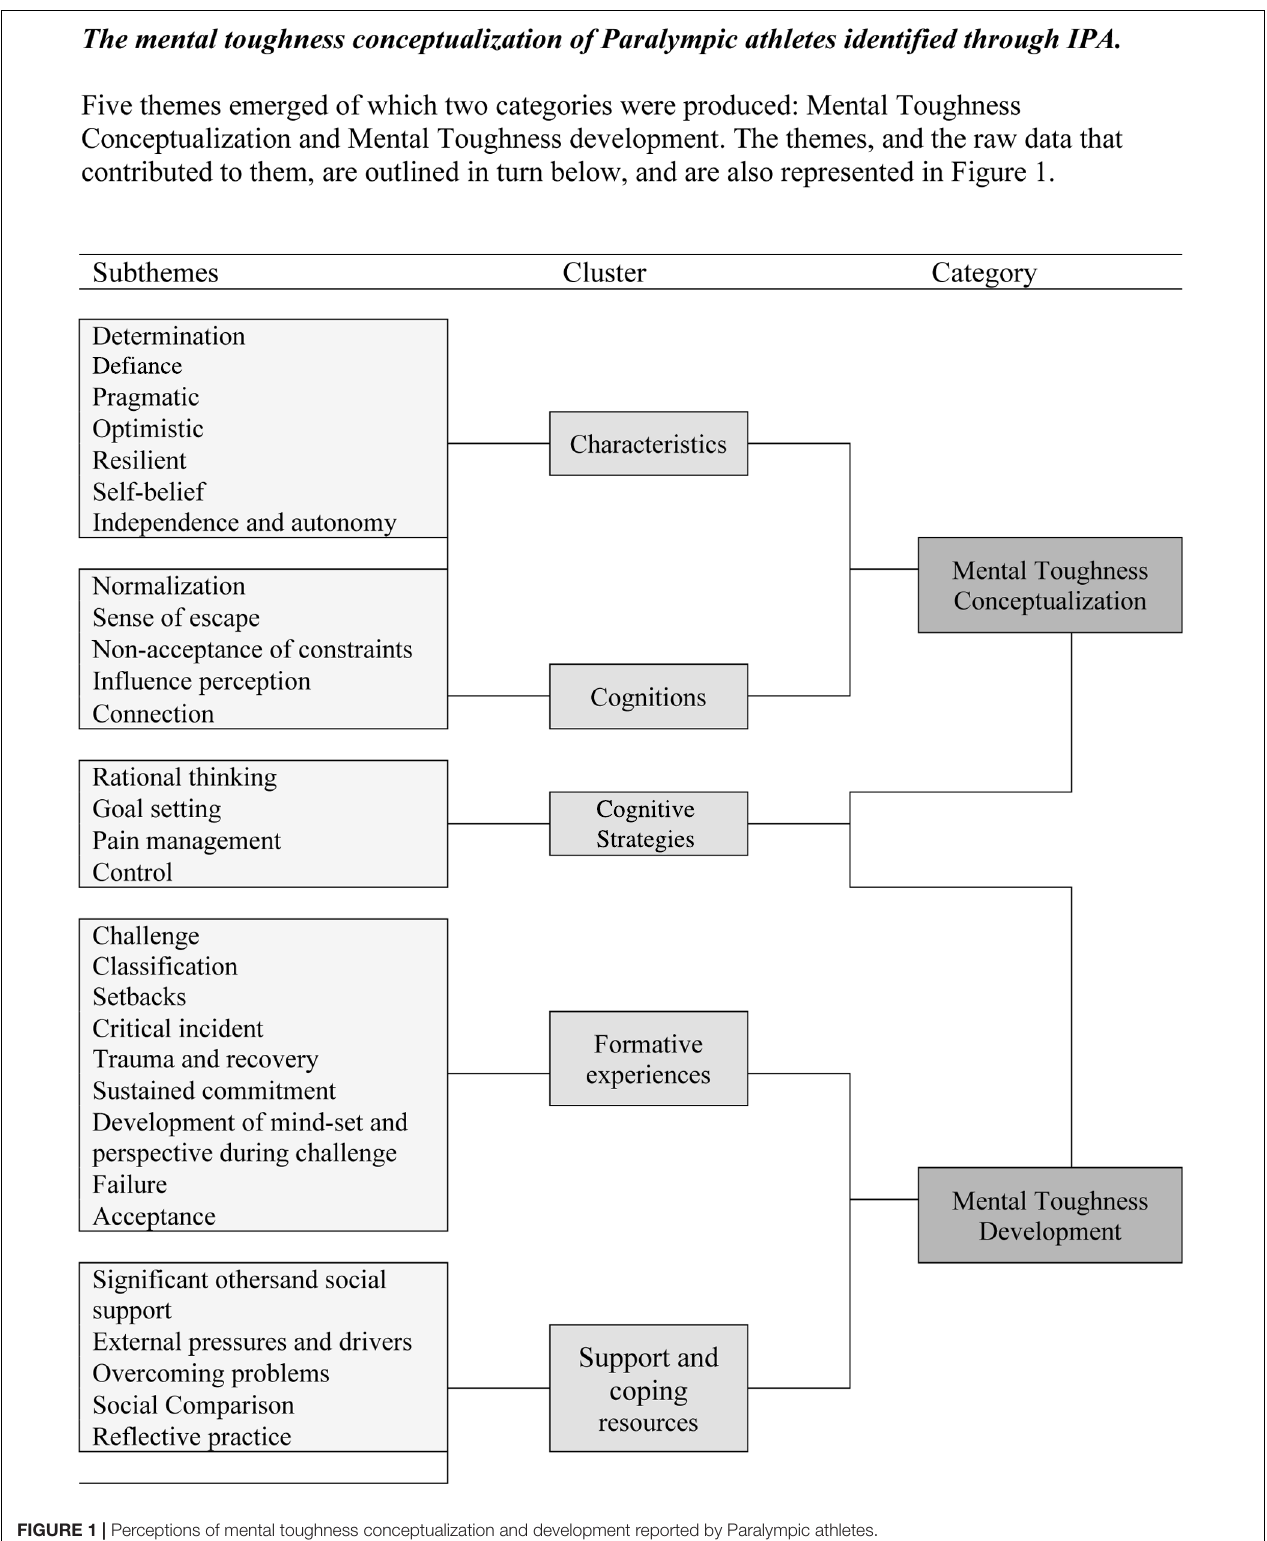
FIGURE 1 | Perceptions of mental toughness conceptualization and development reported by Paralympic athletes.